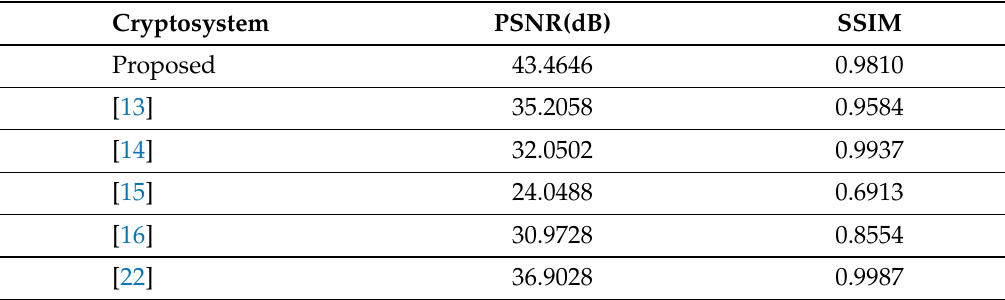
Table 8. Comparison of the average PSNR and SSIM value for our algorithm besides other related